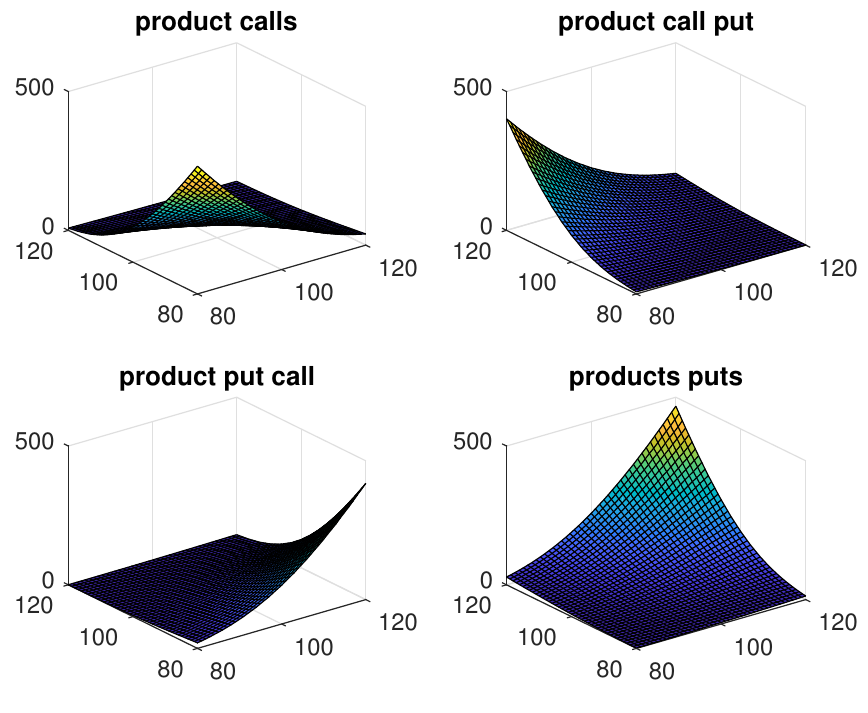
Figure 2. Product option prices. The upper panel is products of calls on JPM with calls and puts on SPY. The lower panel is for products of puts on JPM with calls and puts on